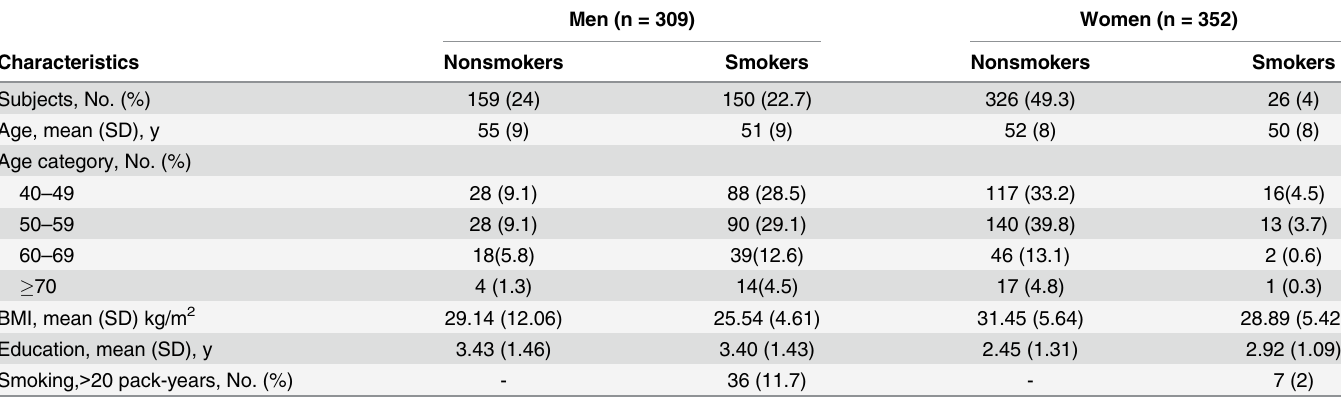
Table 2. Population characteristics for smokers and